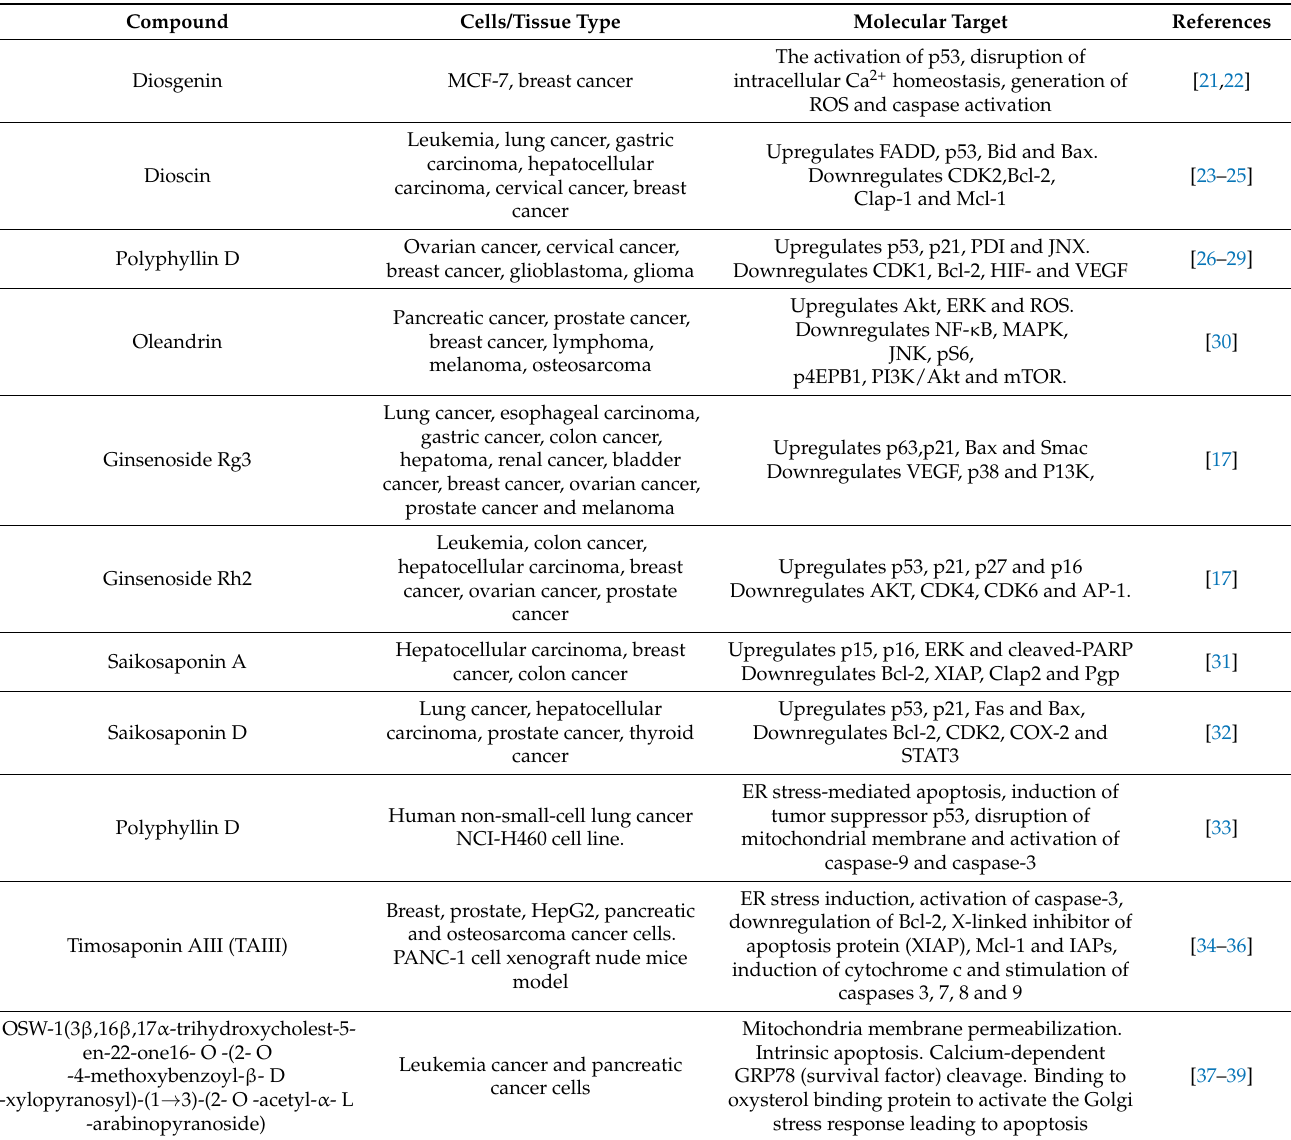
Table 1. Anticancer activities of saponins and